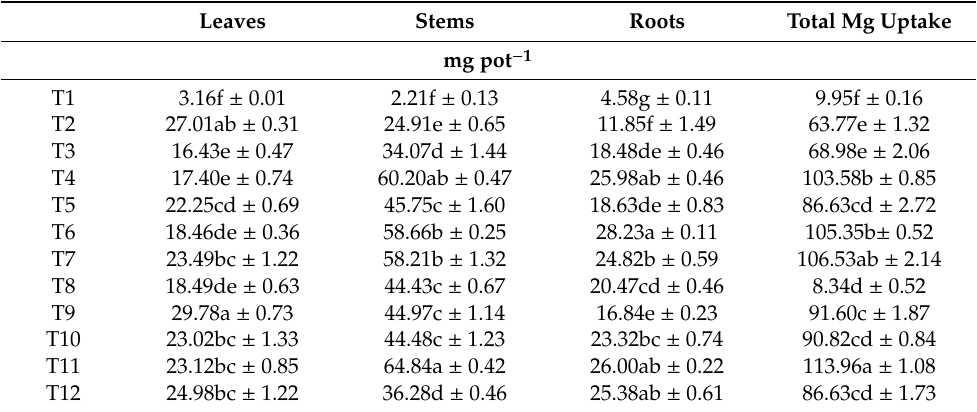
Table 9. E ff ects of treatments on magnesium uptake of leaves, stems, and roots, and total magnesium uptake of maize at tasseling